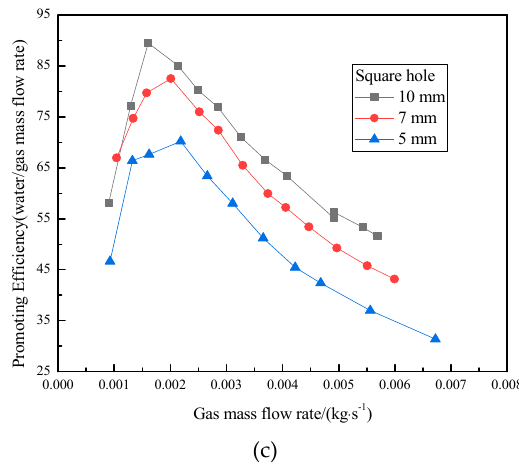
Figure 6. Changes of efficiency of lifting pumps with three different intake areas at submergence ratio of 0.5. ( a ) Intake area form I; ( b ) intake area form II; ( c ) intake area form III.